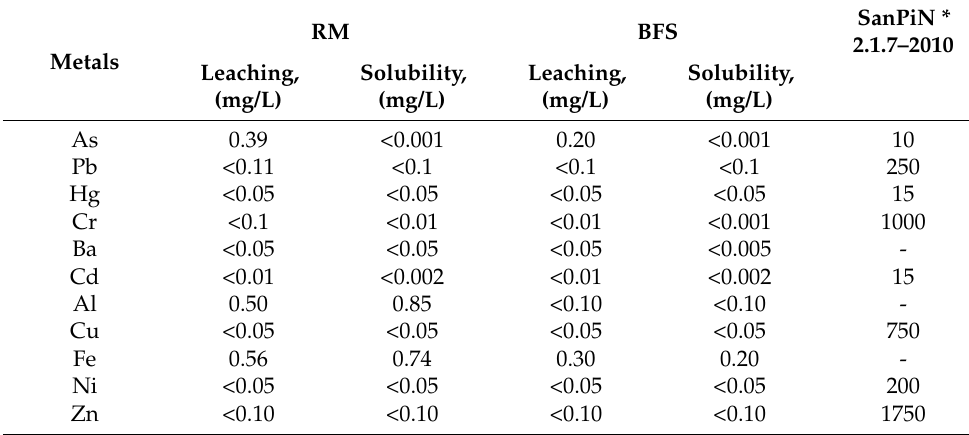
Table 4. Solubility and leaching of toxic metals in RM and BFS.